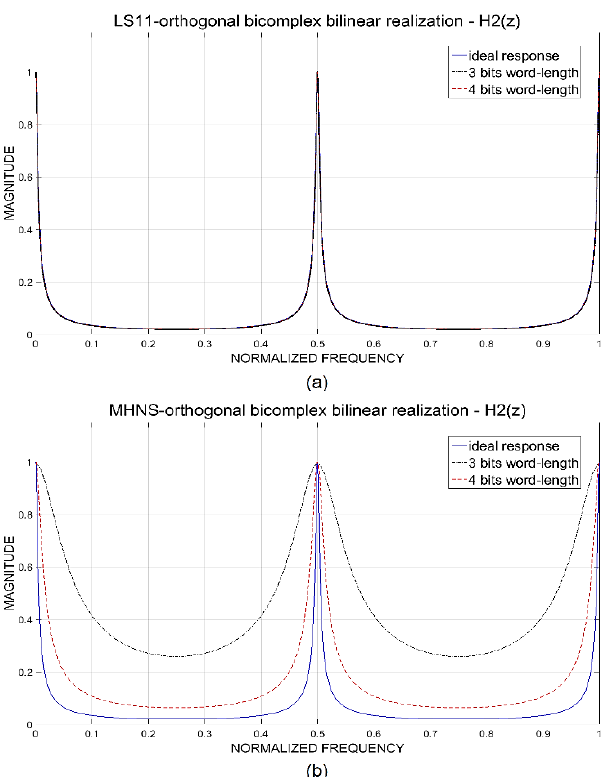
Fig. 9. Magnitude responses of the bicomplex orthogonal real-coefficient functions H 2 ( z ) for different word-lengths: (a) LS 11-based; (b) MHNS -based.